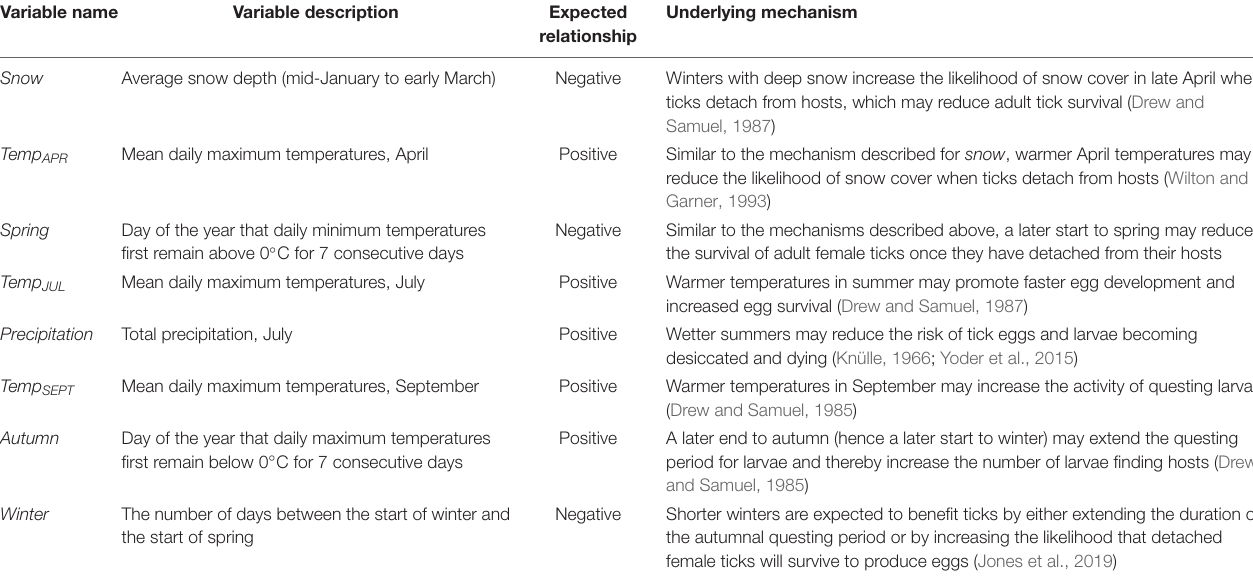
TABLE 2 | Hypotheses pertaining to the influence of weather variables on tick burdens for moose as indicated by the extent of hair loss (see Figure 1